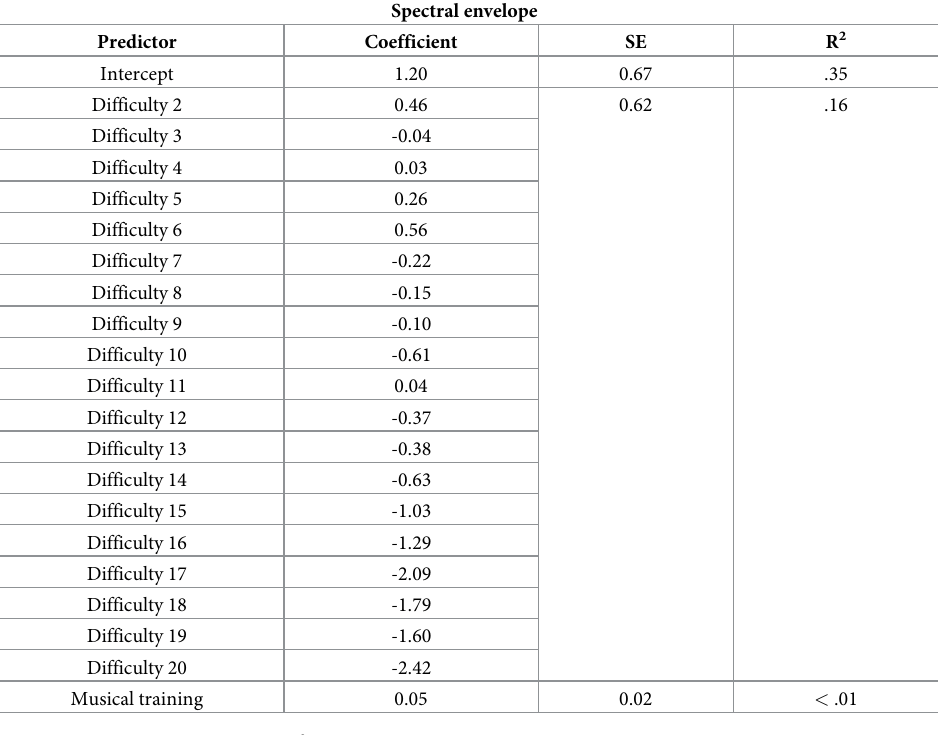
Table 3. Mixed effects multiple linear regression model for spectral envelope feature. Coefficients for each predic- tor (and each degree of difficulty, as relevant) along with standard error (SE) and predictor R 2 are reported along with Pearson’s correlation, 95% CIs, p-value and R 2 for full models in the note below. Spectral envelope